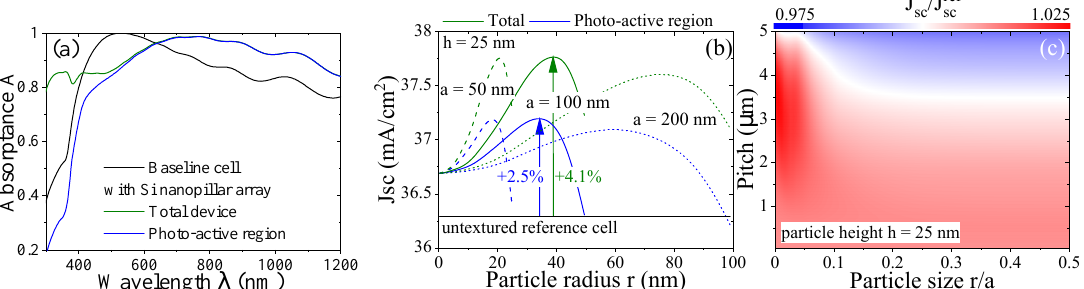
Figure 4. Combined effects of a nanoparticle layer and free carrier absorption with and without parasitic absorption. ( a ) Absorption spectra for the baseline cell, with a Si nanopillar array and partial absorption only within the photo-active region. ( b ) The wavelength-independent short circuit current J sc as a function of nanodisk radius showing results for both the total device absorption (green) and excluding absorption in the nanoparticles (blue). The untextured baseline cell is given as a reference. ( c ) Contour of the J sc for a range of lattice parameters and particle sizes excluding parasitic